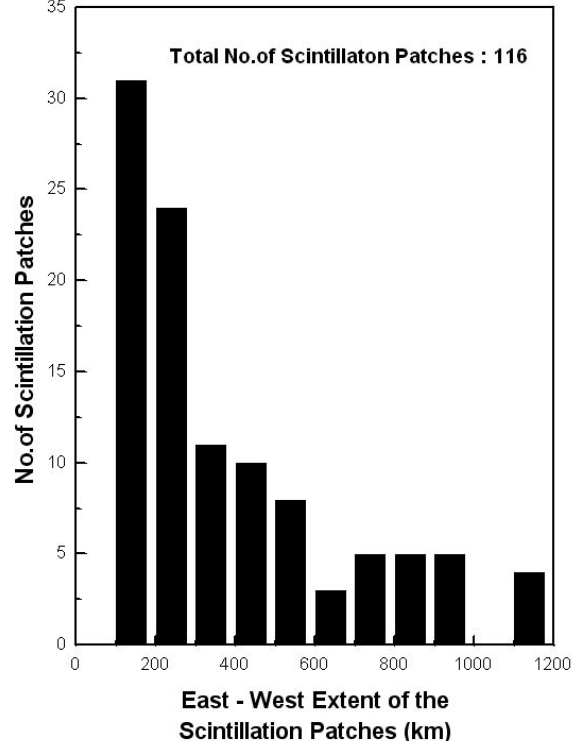
Fig. 7. Histogram showing the distribution of size (East − West ex- tent) of PBI